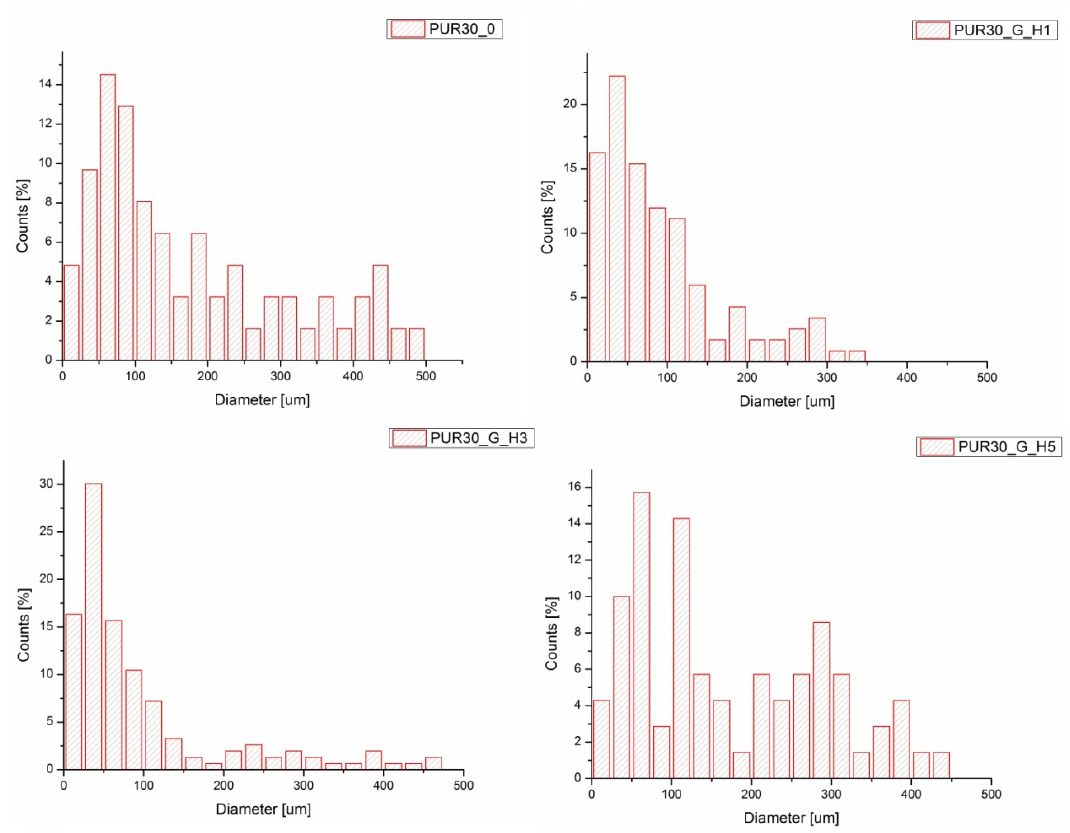
Figure 6. Pore size distributions for PUR30_0, PUR30_G_H1, PUR30_G_H3, and PUR30_G_H5. Table 2. The porosity of unmodified and modified PUR scaffolds.